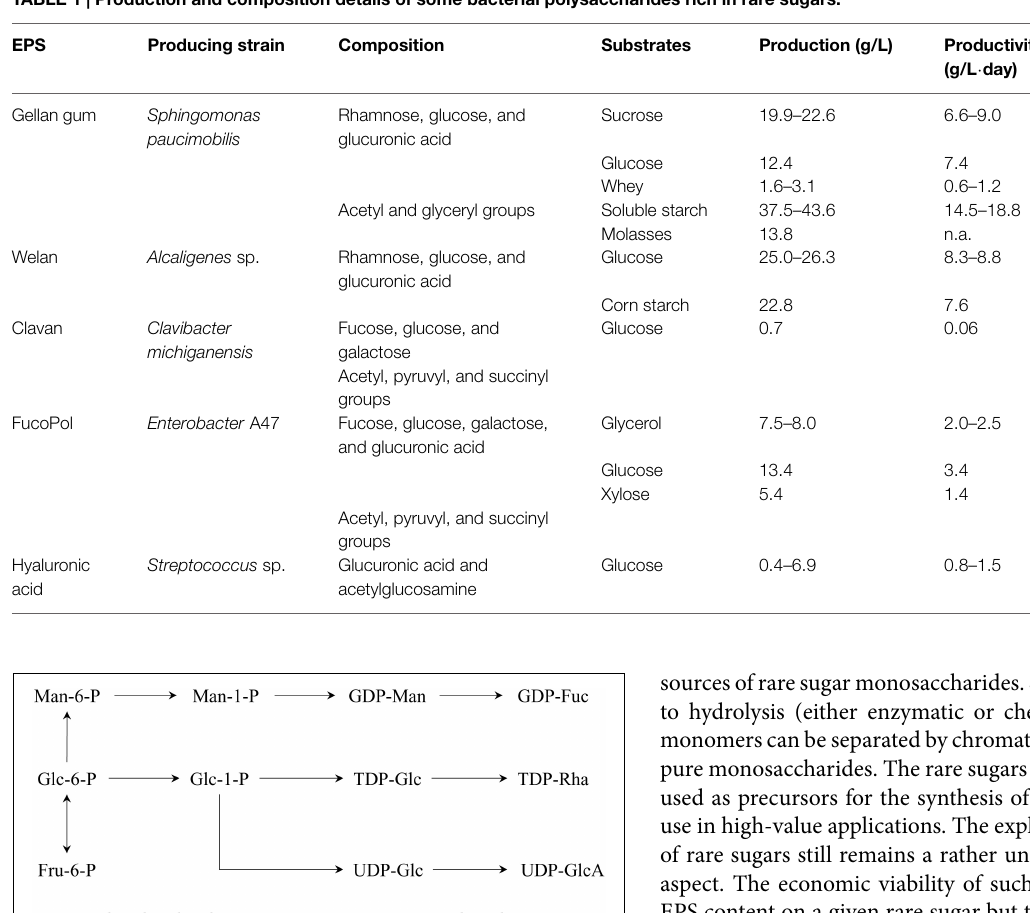
TABLE 1 | Production and composition details of some bacterial polysaccharides rich in rare sugars.